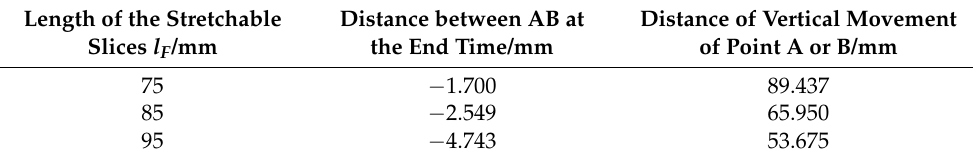
Table 2. Motion distance of the point under different lengths of flexible slices. Length of the Stretchable